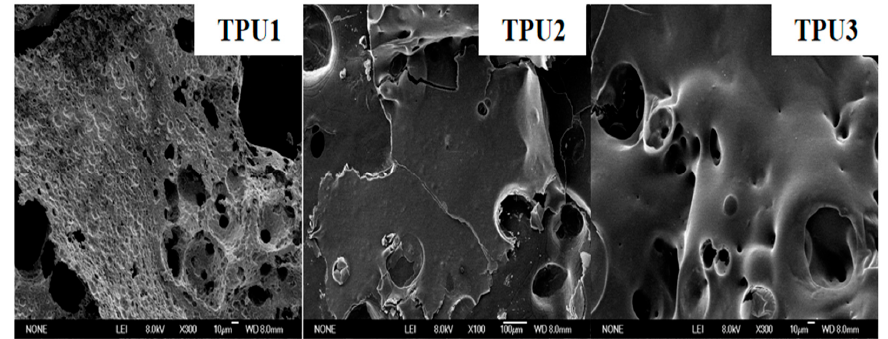
Figure 11. SEM images of the carbon residues of TPU composites. The carbon residues of TPU1 and TPU3 were analyzed by XRD and Raman tests, and the results are shown in Figure 12. It can be found in Figure 12a that diffraction peaks of MoO 3 and MoS 2 appeared in the XRD pattern of the carbon residue of TPU1. As shown in Figure 12b, the XRD pattern of the carbon residue of TPU3 not only has characteristic peaks of metal oxides such as MoO 3 , NiO, Ni 2 O 3 and Co 2 O 3 , but also has a diffraction peak of graphite crystallite around 2 θ = 25°. The degree of graphitization of carbon residues was determined by Raman spectra, as shown in Figure 12c,d. It is clear from both Raman spectra that obvious peaks are observed at 1360 cm − 1 and 1598 cm − 1 , representing the D and G bands, respectively. The area ratio of the D band and G band (I D /I G ) is widely used to determine the degree of graphitization of carbon residues. The lower the value of I D /I G , the higher the degree of graphitization of the carbon residues [40]. The I D /I G value of TPU3 is 2.71, lower than that of TPU1 (3.19), which indicates that the addition of NiCo- LDH/MoS 2 is beneficial to improving the degree of graphitization of carbon residues.